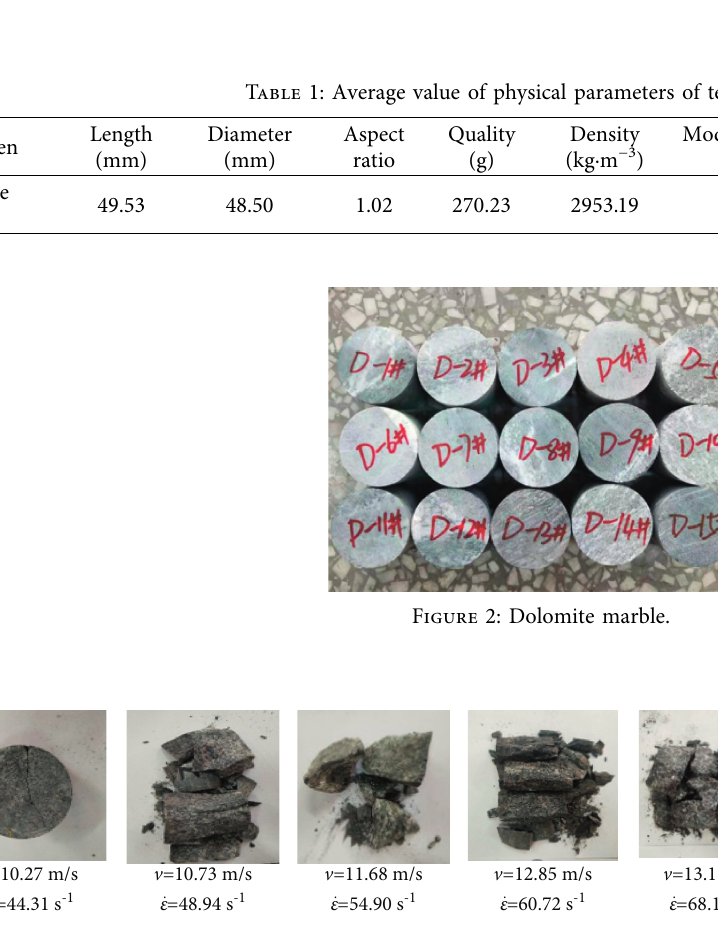
Figure 3: Failure modes of dolomite marble under different impact